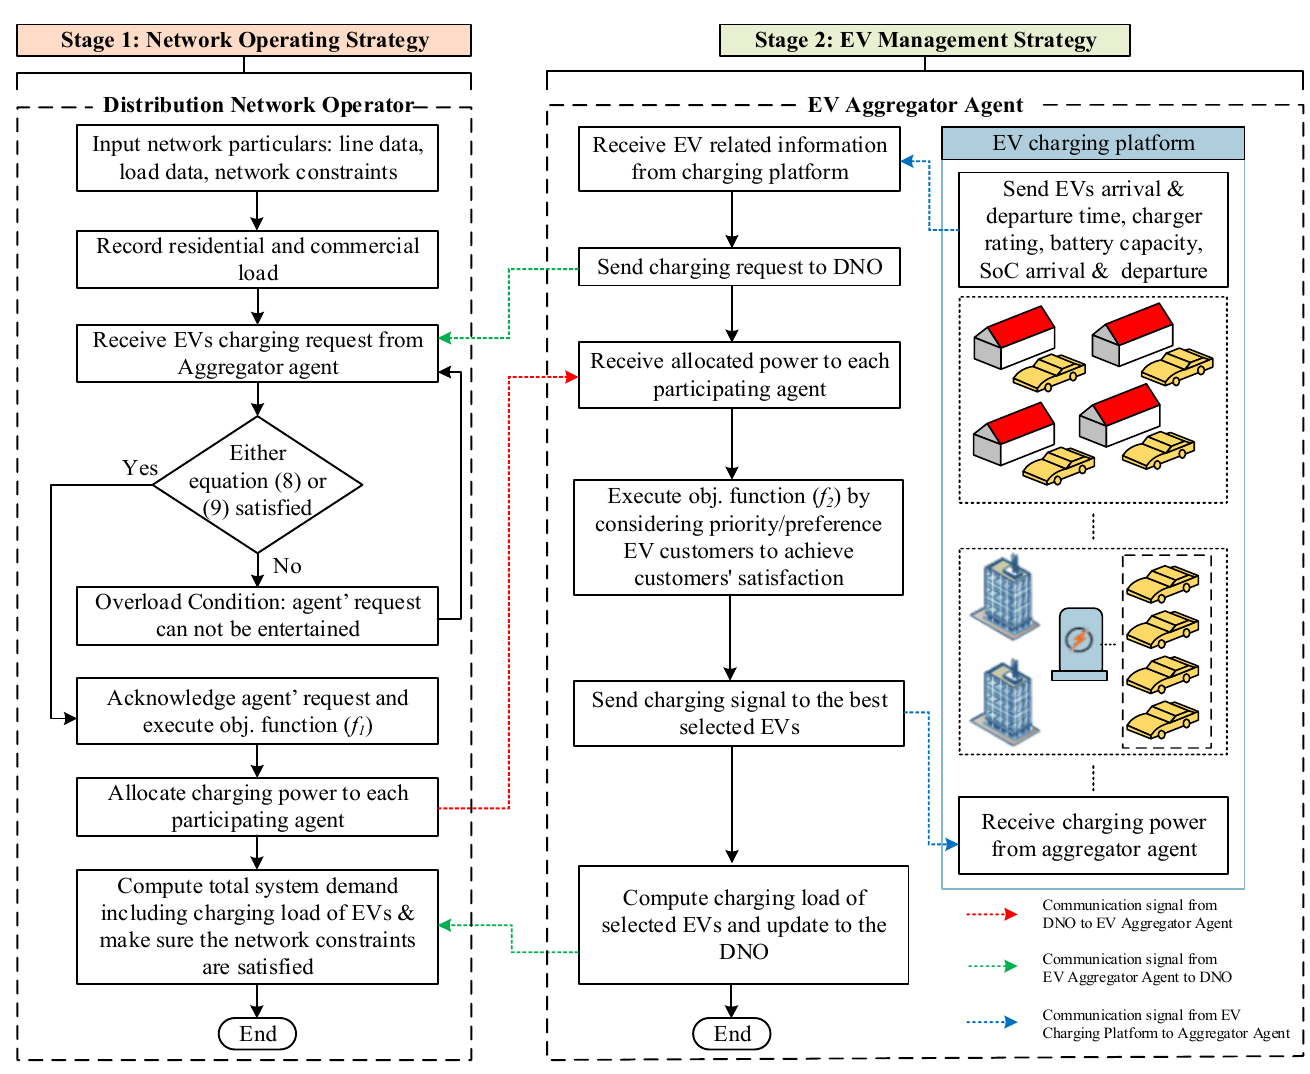
Figure 3. Coordination strategy between two stages .